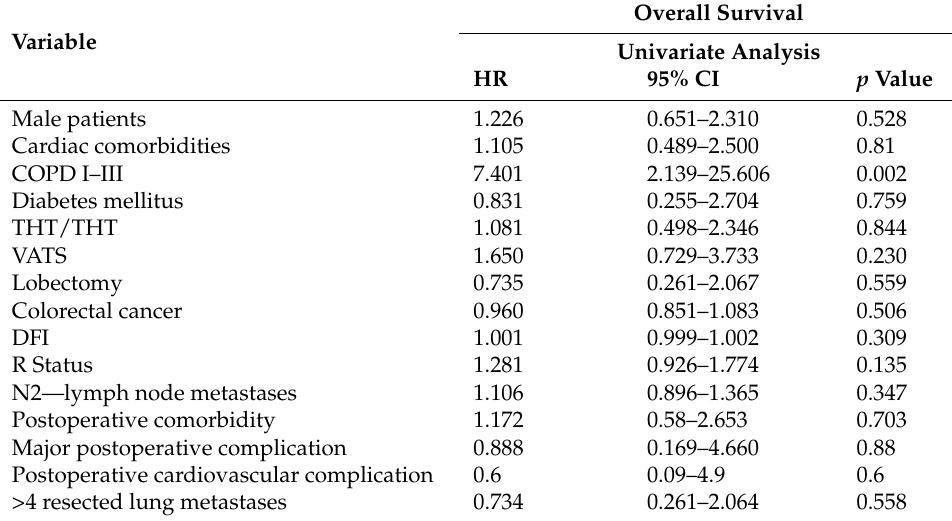
Table 6. Univariate analysis of prognostic survival factors in the elderly population.